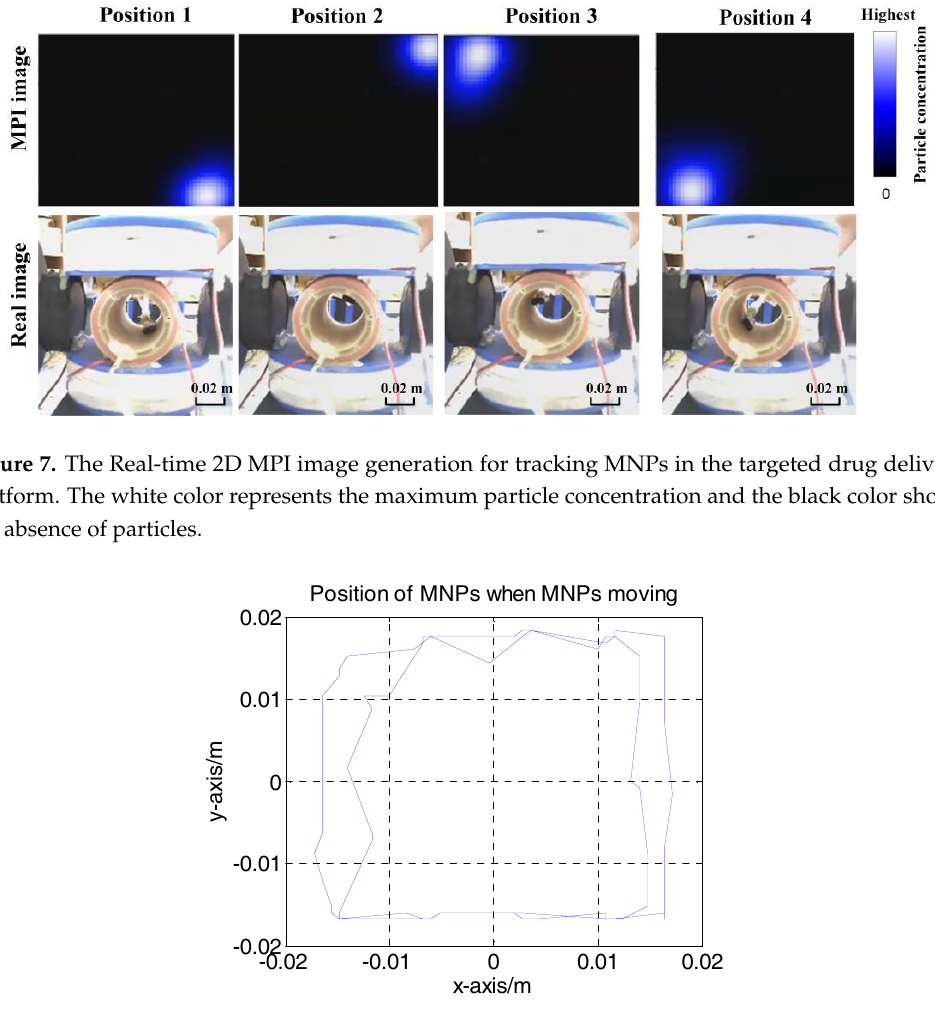
Figure 6. The difference between the MPI position and the real sample position when MNPs are at the center. Sensors 2017 , 17 , x FOR PEER REVIEW